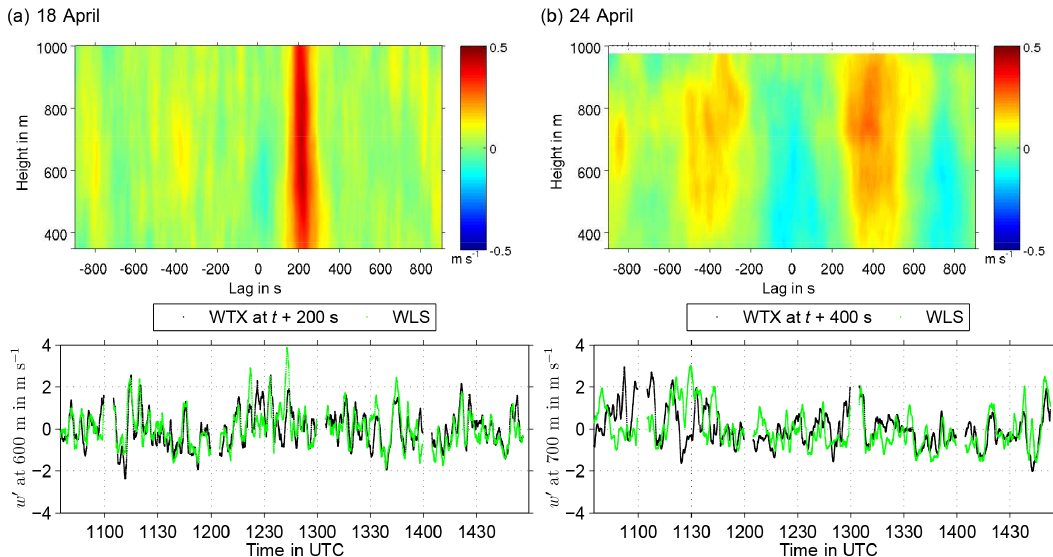
Figure 14. Cross correlation functions between w (cid:48) time series (10:30–15:00UTC) at Hambach and Wasserwerk (WTX and WLS200, re- spectively) for all range gates between 380 and 1000m (upper row) and w (cid:48) time series ( ± 50-s running average) for both lidars at one range gate (lower row) on 18 April (a) and 24 April 2013 (b)